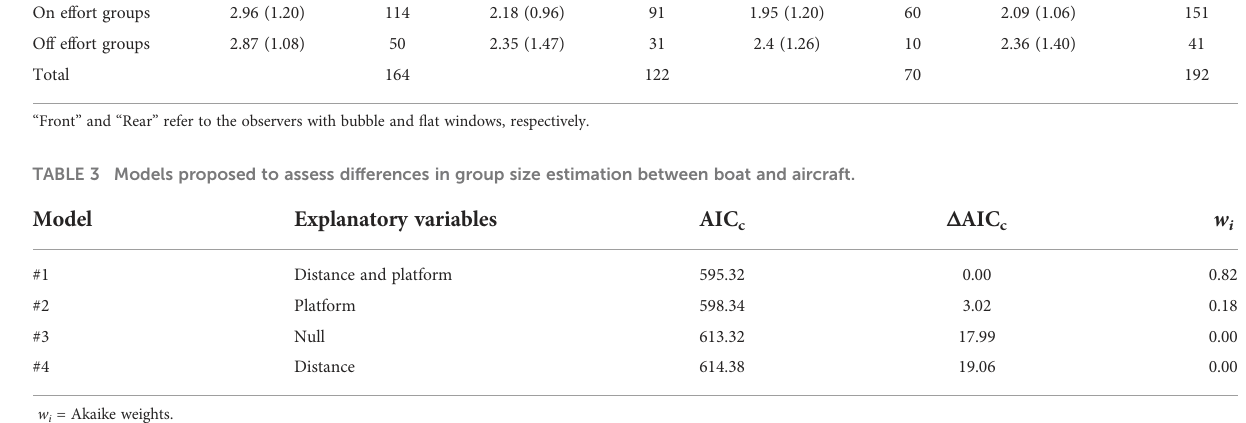
TABLE 4 Model parameter estimates for the best model (#1) in Table 3 , above. Parameter Intercept